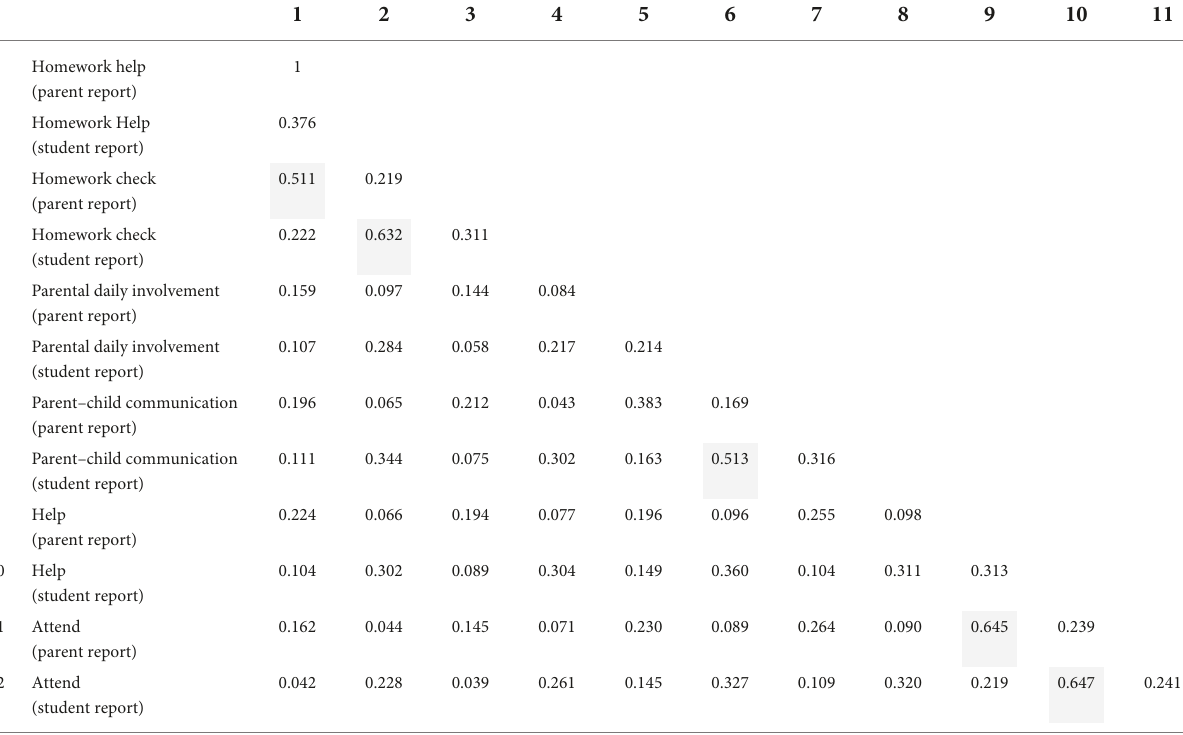
TABLE 2 Correlations among parental involvement